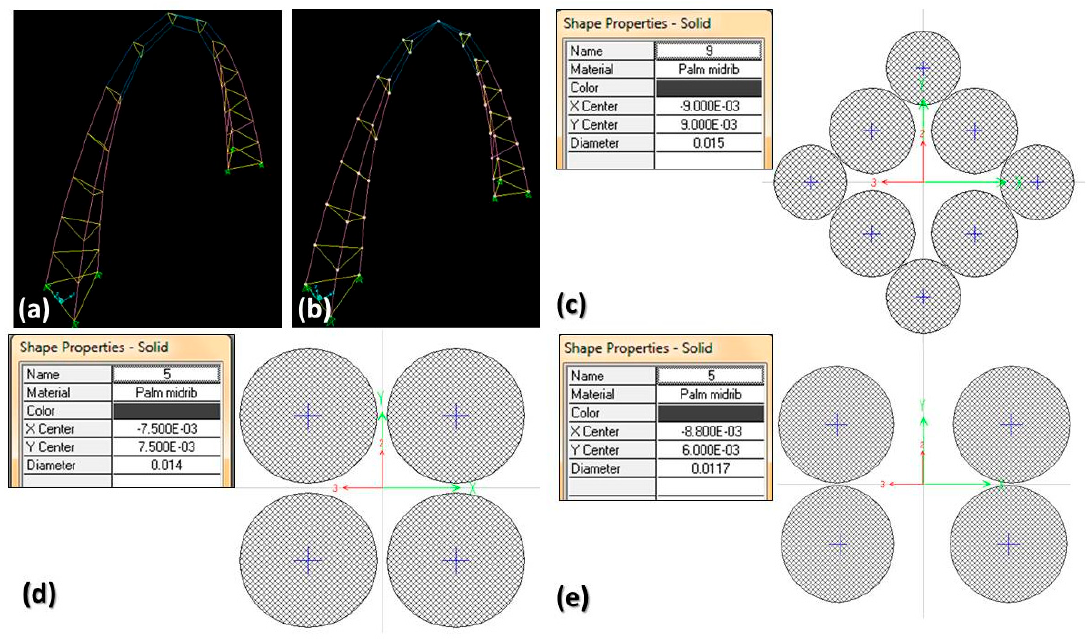
Figure 27. The setup of the digital model of the system in SAP2000. ( a ) The digital model before updating to match the specimens. ( b ) The updated digital model. ( c ) Cross-section of the bottom bundle. ( d ) Cross-section of the middle bundle. ( e ) Cross-section of the portion above overlap. (dimensions in m).